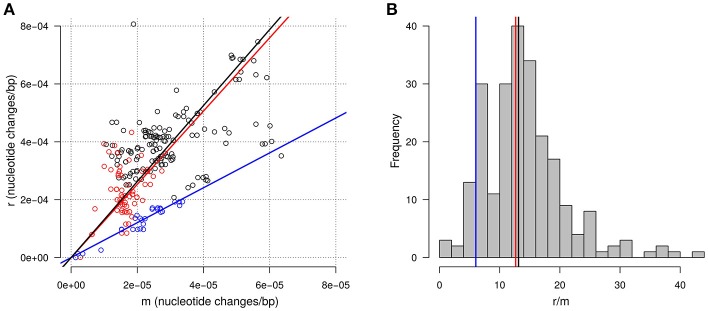
Recombination and mutation in divergence between closely related isolates. (A) Relationship between the amount of nucleotide changes arising from recombination (r) and from mutation (m). Each point represents a pair of closely related isolates. Colors highlight pairs within two groups of isolates in CC-ST10 according to the topology of the tree built on AT-profiles: blue for isolates from FI055 to DK002 (group B in the text) and red for isolates from MH1 to CH8 (group C in the text). The lines represent the line with intercept zero and slopes equal to the median of r/m for all pairs (black), for pairs in group B (blue), and for pairs in group C (red). (B) Distribution of the estimated r/m ratio across pairs of isolates. Vertical lines correspond to the slopes of the lines in (A).